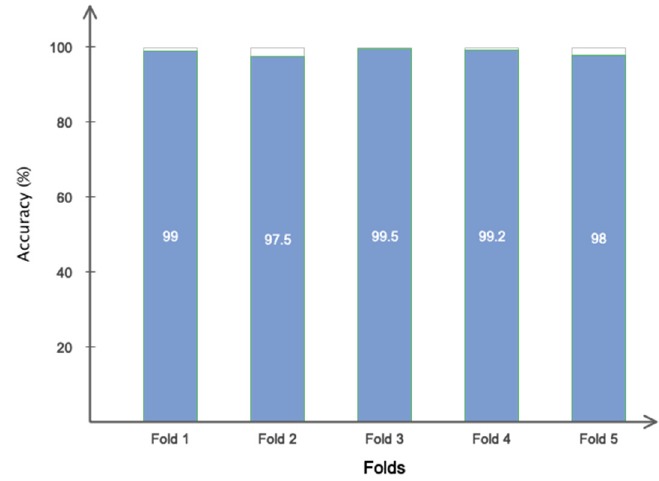
Figure 14. The 5-fold cross-validation on data. Table 2. The leukemia diagnostic accuracy of various